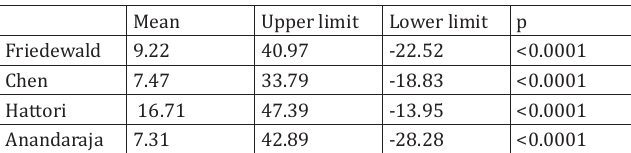
Bland-Altman plot results of the four formulas.